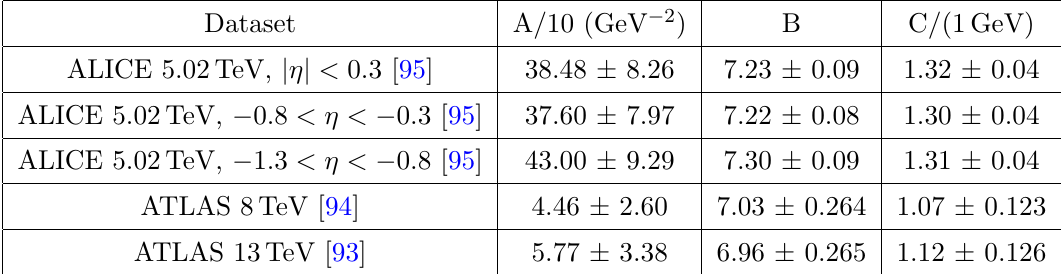
Table 1. Fitted values of parameters in eq. (5.2) for three data sets. Both central values and statistical errors are